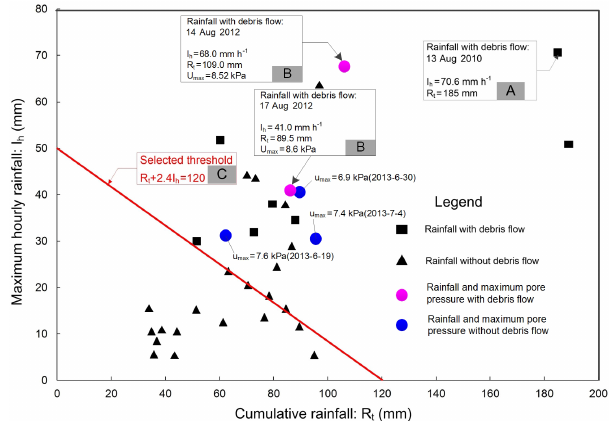
Figure 10. Warning threshold combined with rainfall and pore pres-